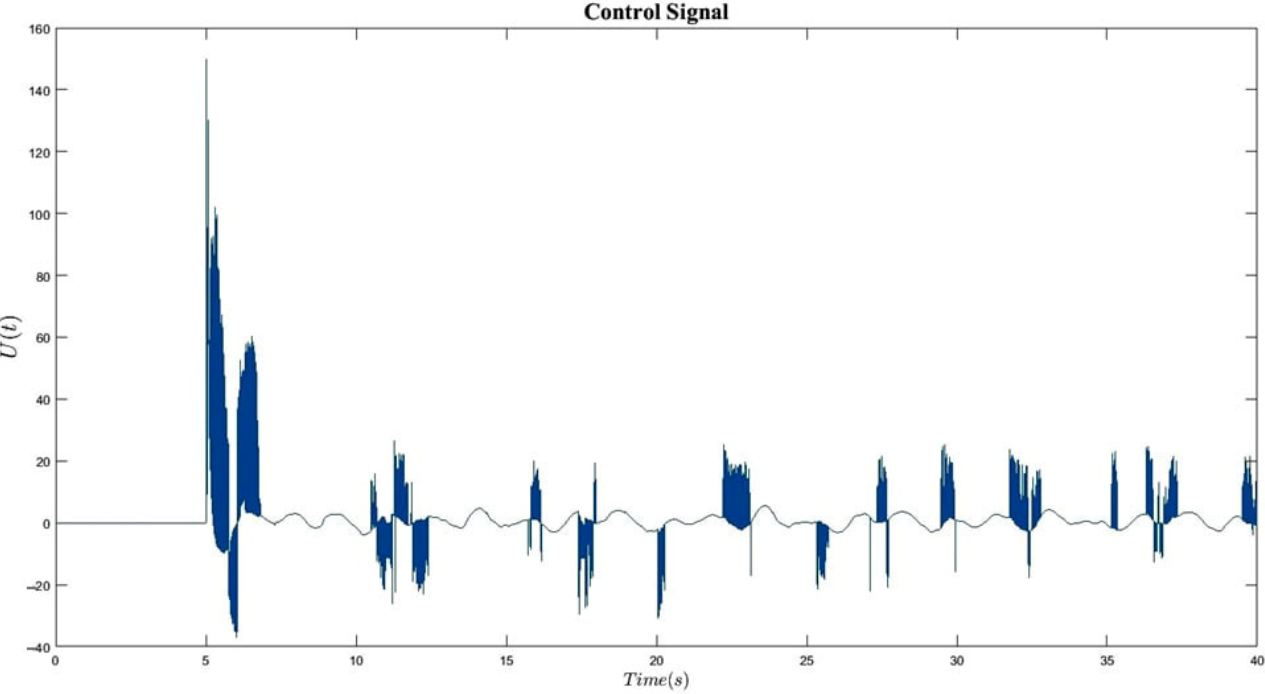
Figure 4. Synchronization error of the master and slave systems.